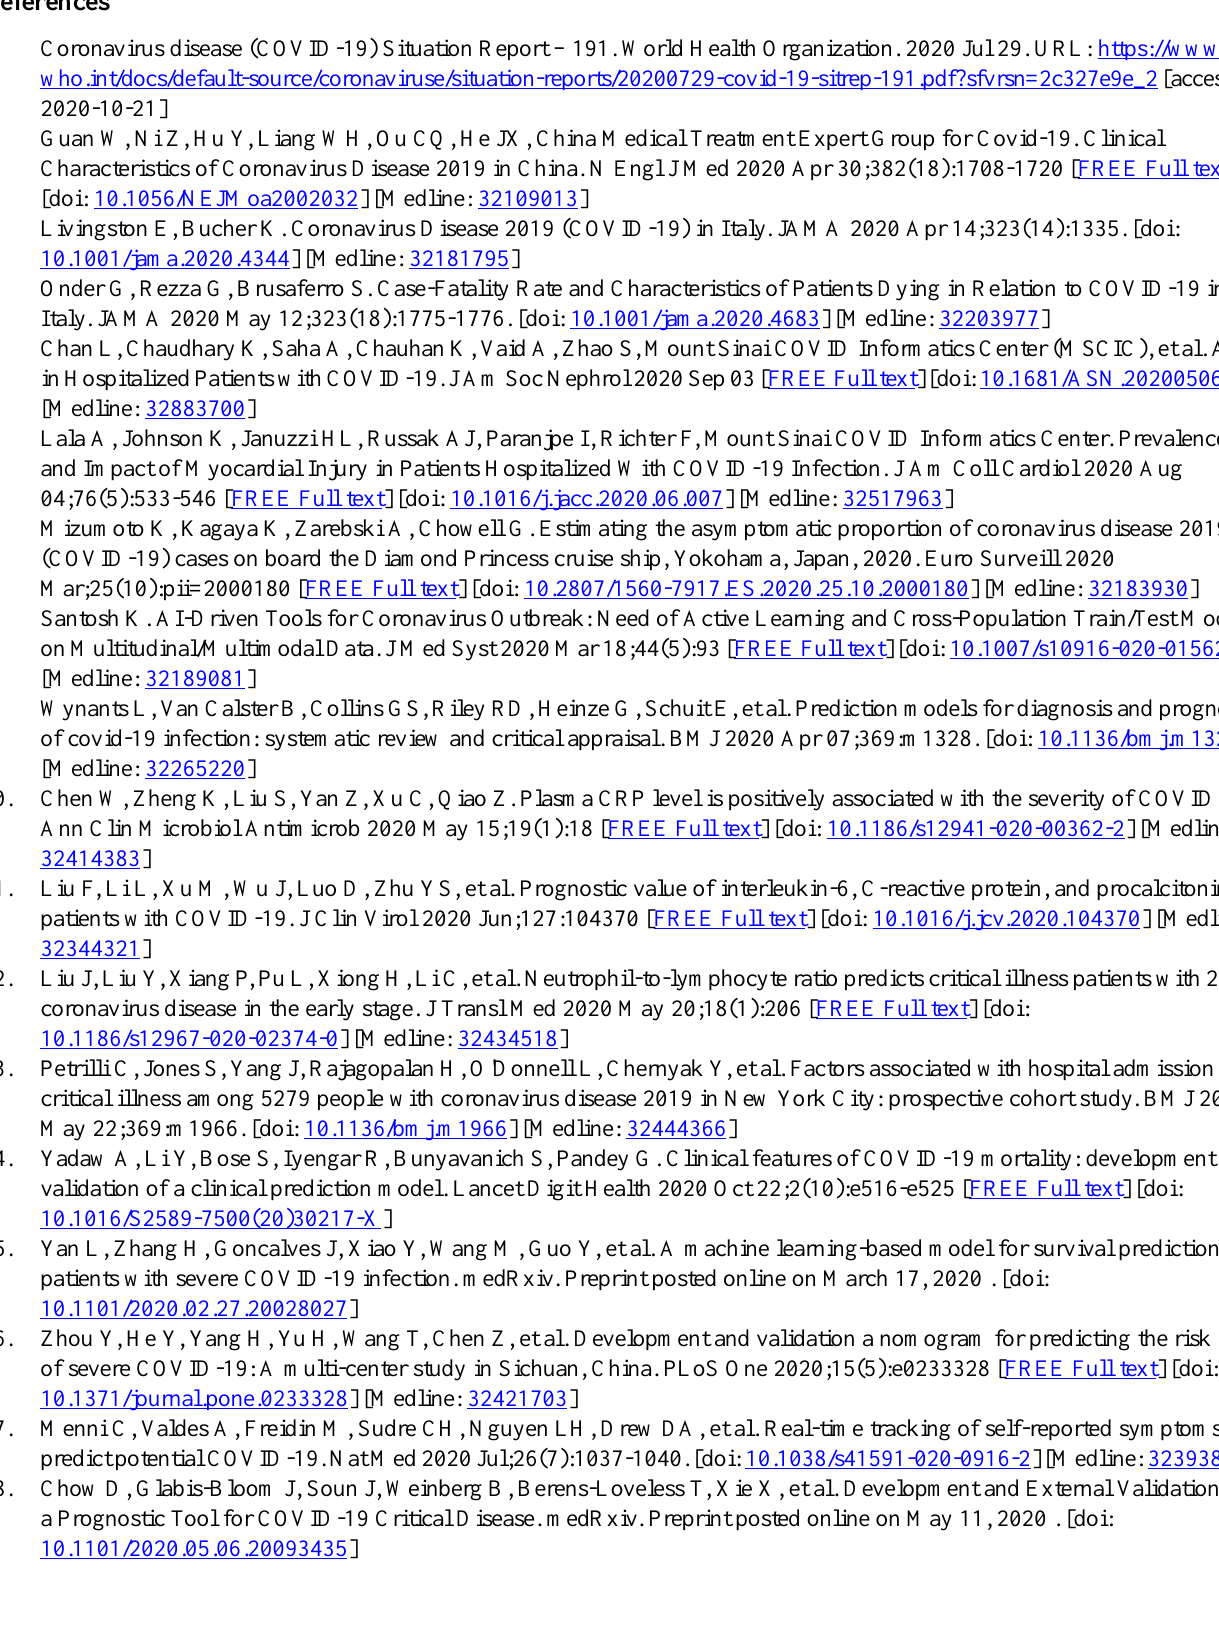
Supplementary Table 6: Clinical features ranked in decreasing order based on their significance (most significant predictor=1, least significant predictor=10) for critical event and mortality at 7